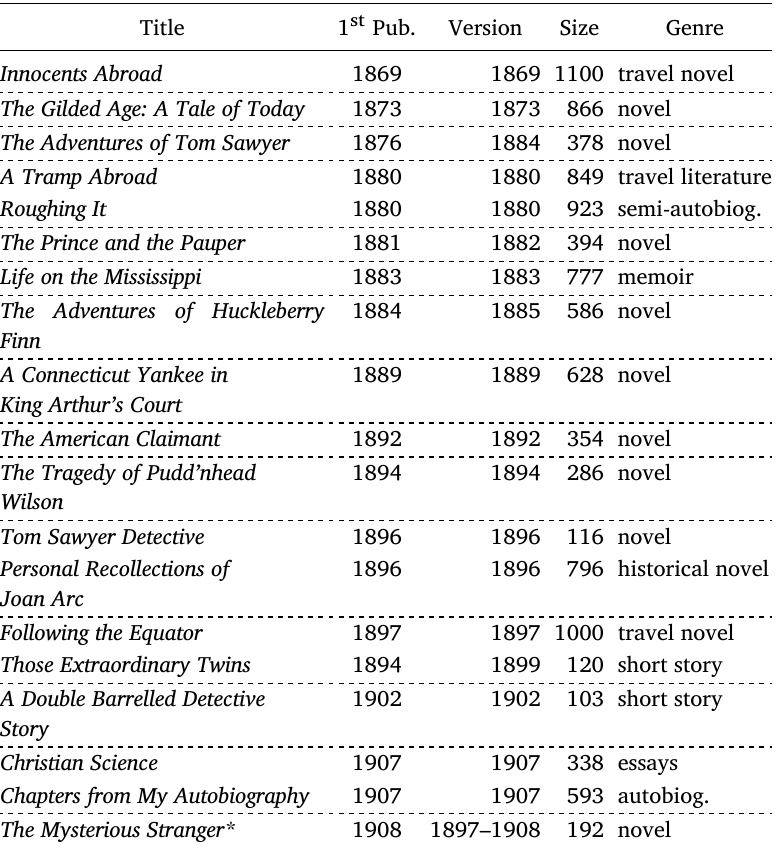
Table 2: Collected works for Mark Twain. Showing ‘Title’, the original publication date (‘1 st Pub.’), version collected (‘Version’), ‘Size’ in kilobytes and ‘Genre’ type. The dashed lines indicate the boundaries for compression, i.e. which of the works are combined into one temporal interval (see Section 4.3 for discussion of the compression technique